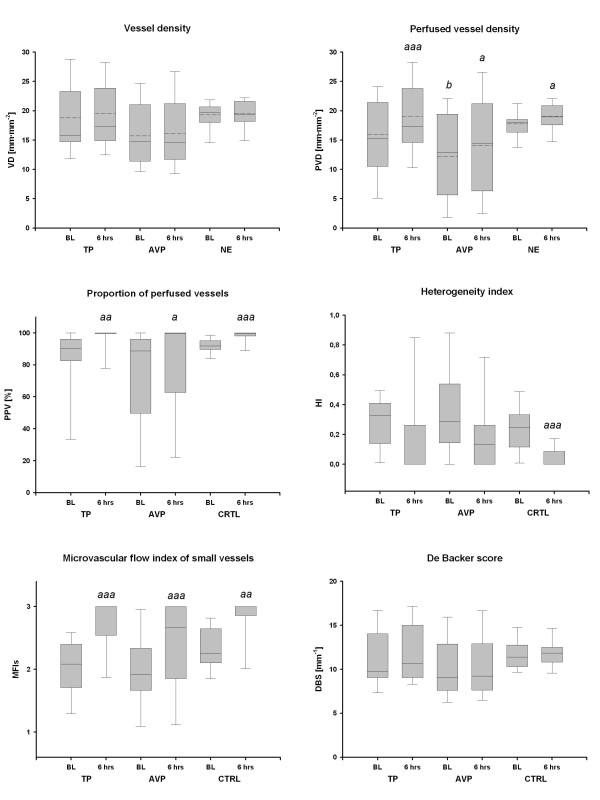
Absolute changes in microcirculatory variables. AVP, arginine vasopressin; BL, baseline; DBS, De Backer Score; HI, heterogenity index; MFI, microvascular flow index of small vessels (Ø < 20 μm); NE, norepinephrine; CTRL, control; PPV, proportion of perfused vessels; PVD, perfused vessel density; TP, terlipressin; VD, vessel density. Solid lines, median; dashed lines, mean; boxes, 25th and 75th percentiles; whisker caps, 10th and 90th percentiles. aP < 0.05, aaP < 0.01, aaaP < 0.001 vs. BL; bP < 0.05 vs. CTRL.